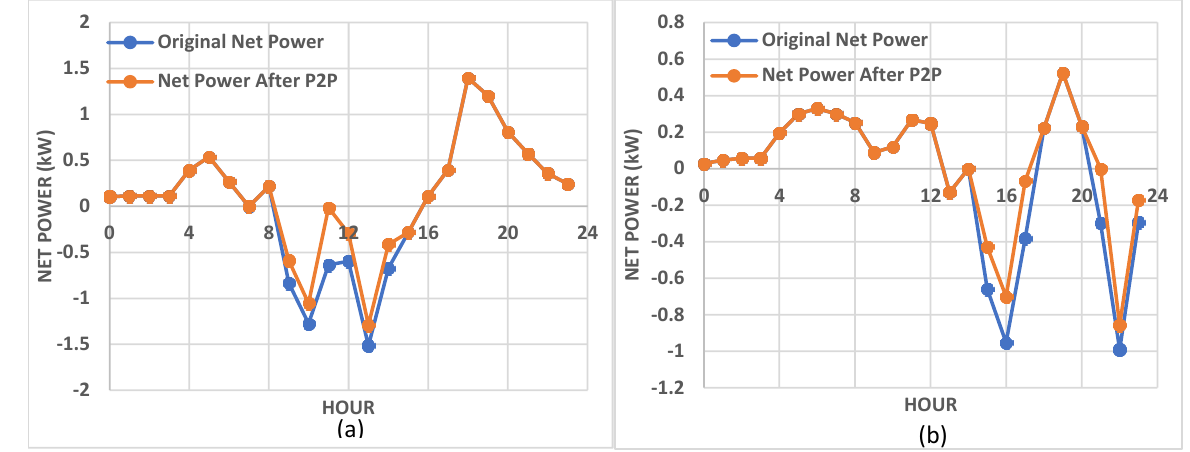
Figure 13. Difference of net power curves ( a ) PV prosumer ( b ) Wind turbine prosumer. Variation of the Inconvenience Factor α